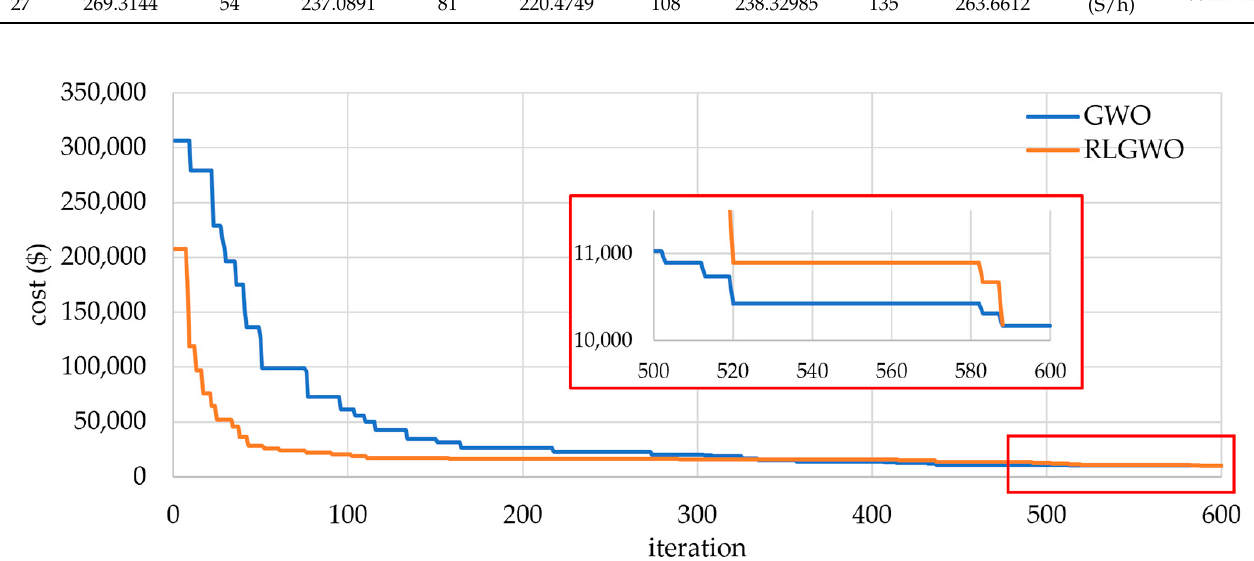
Figure 12. Comparative convergence characteristic of original GWO and proposed RLGWO algorithm for the 160-unit system.